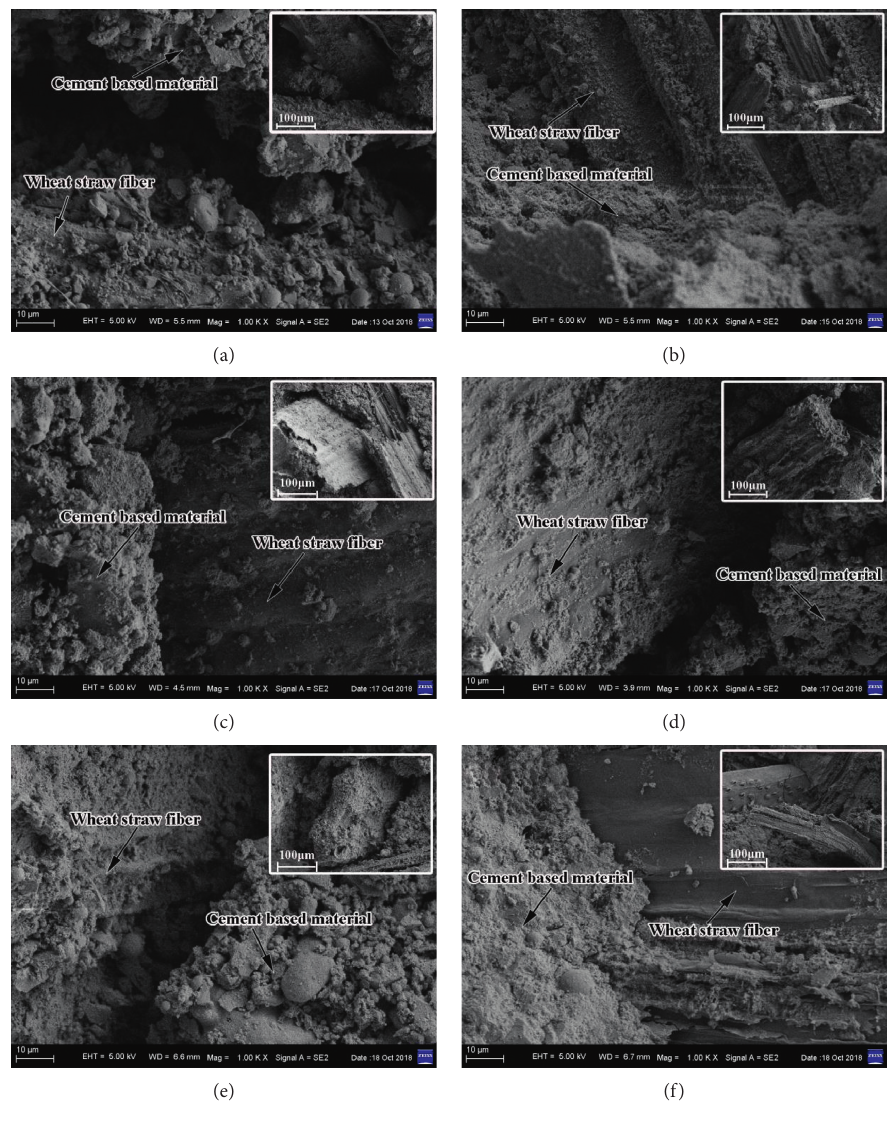
Figure 9: SEM graphs of WSFCC